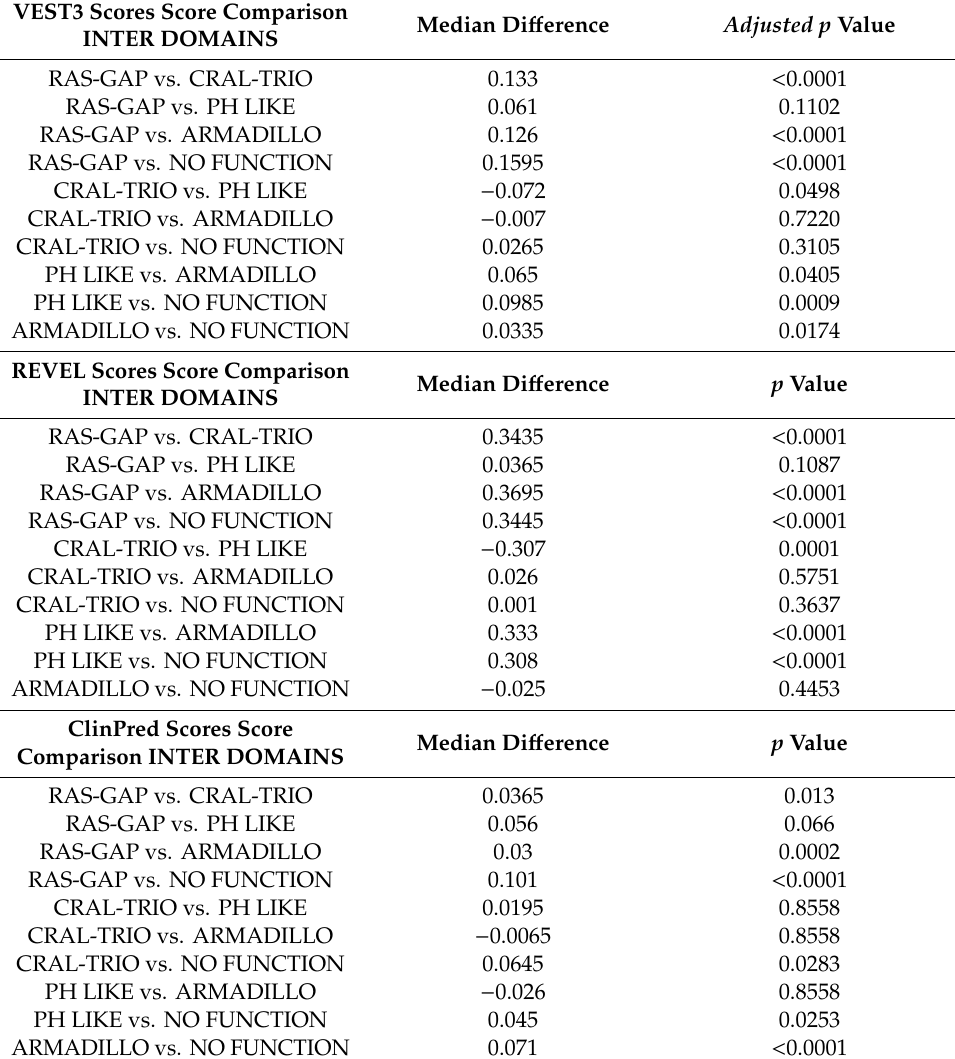
Table 3. Pairwise comparison of score distribution in the NF1 protein domain. Results of Dunn’s test corrected for multiple comparisons with the Benjamini-Hochberg method are